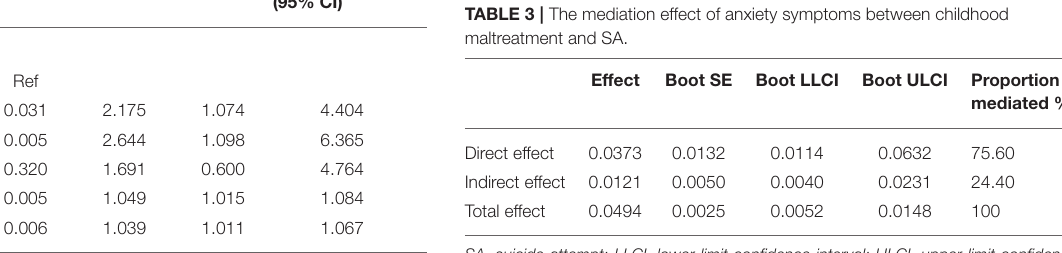
Frontiers in Psychiatry |